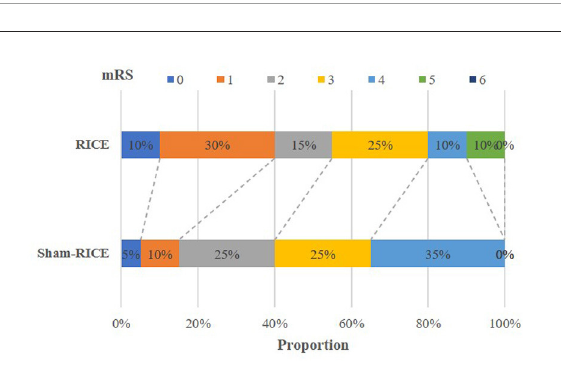
FIGURE2 mRS shift: the percentage of patients achieving each mRS score at 90d.